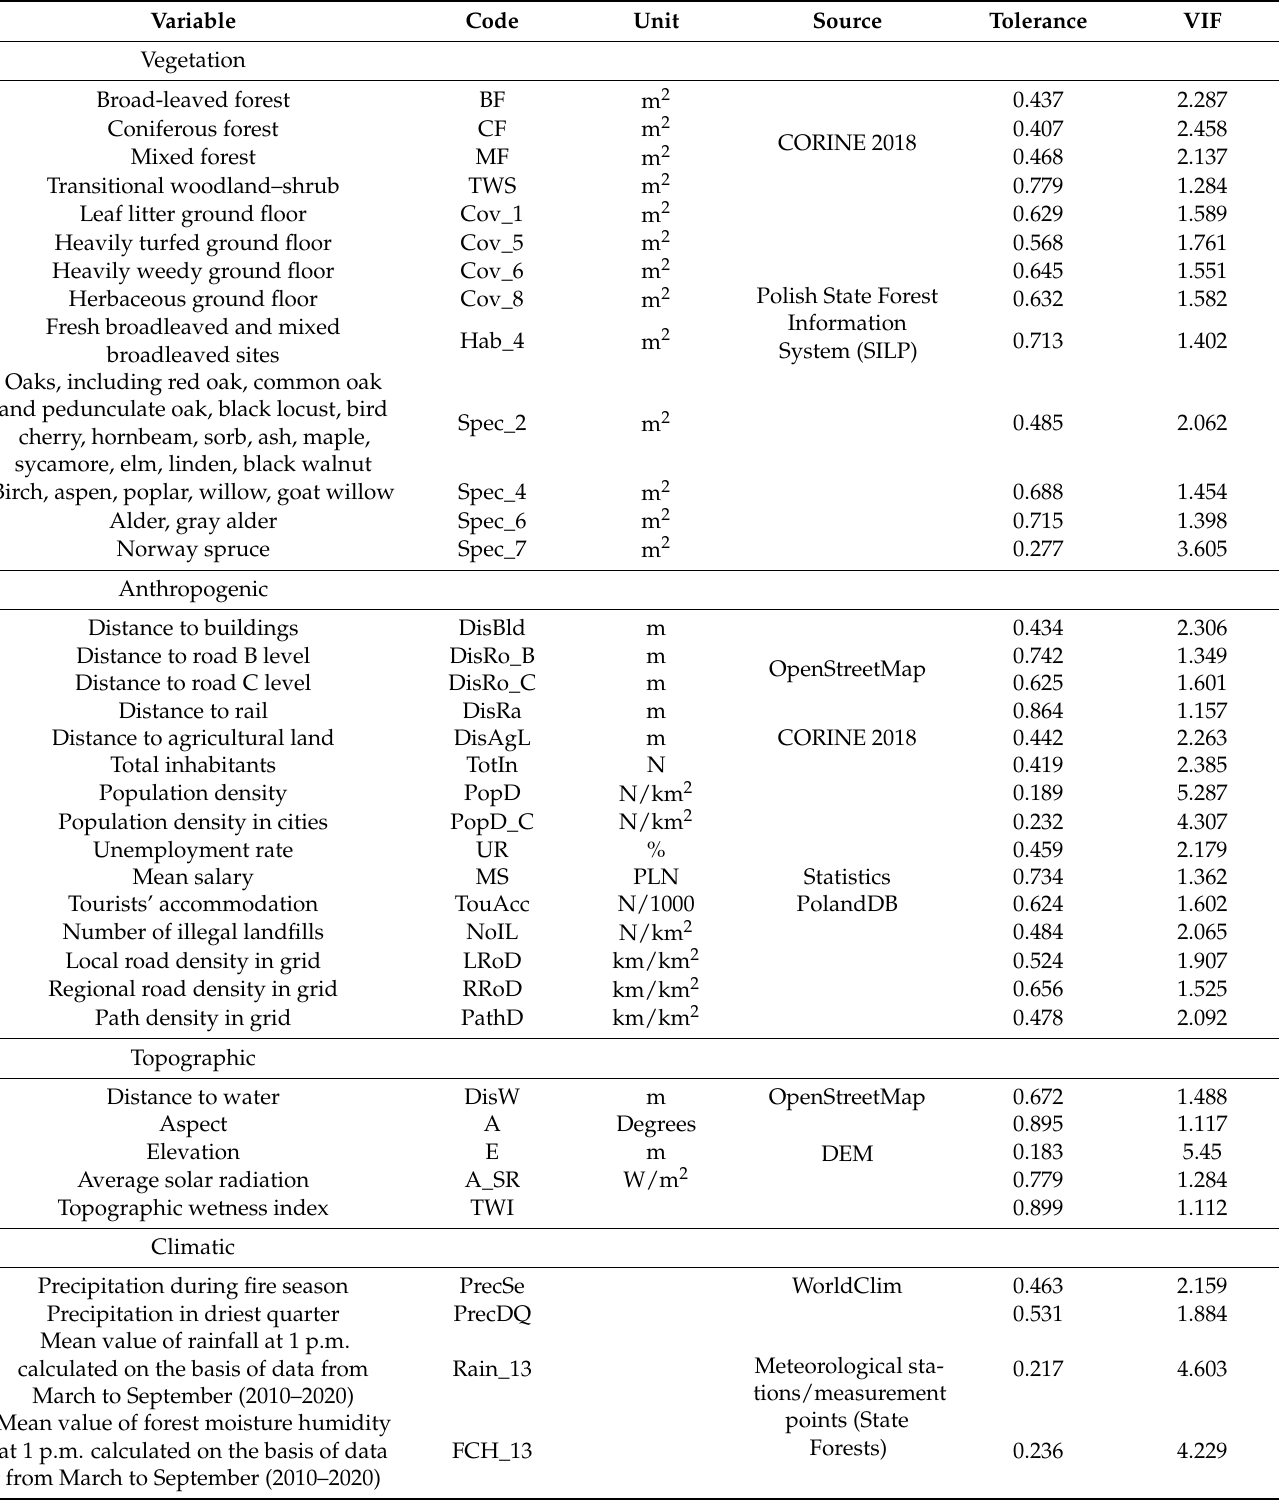
Table A1. Independent variables considered for forest fire occurrence models with codes,